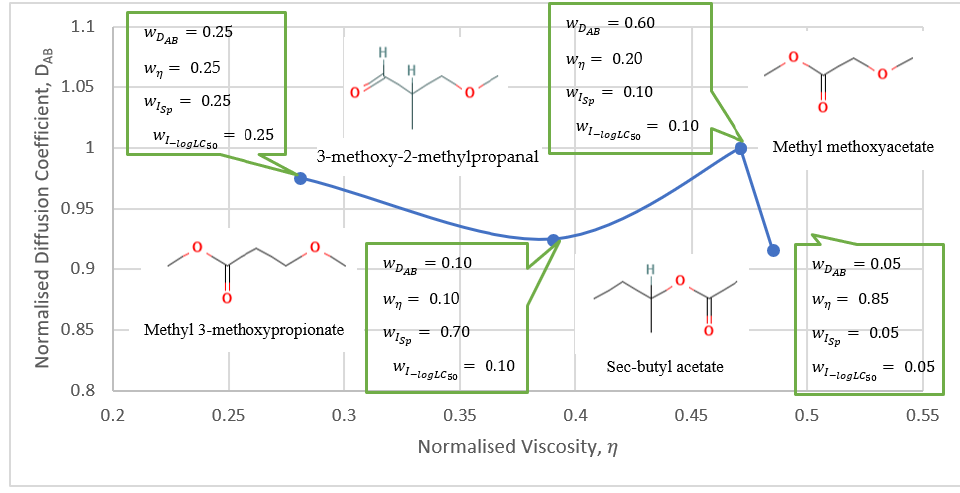
Figure 3. Pareto front from rule 4.